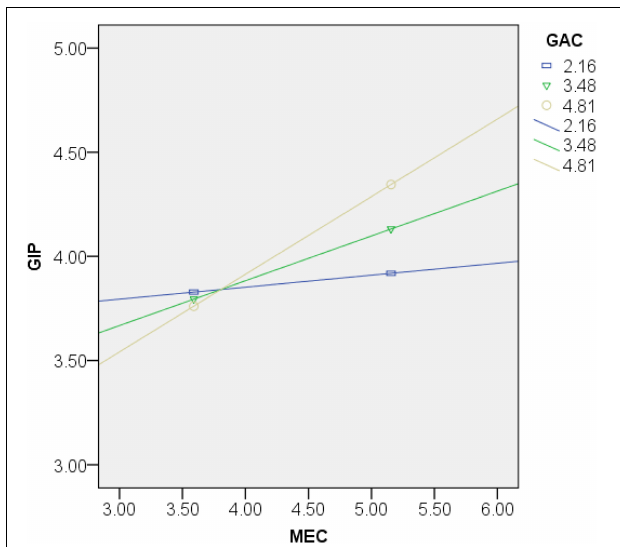
FIGURE 2 | The moderating efffect of green absorptive capacity